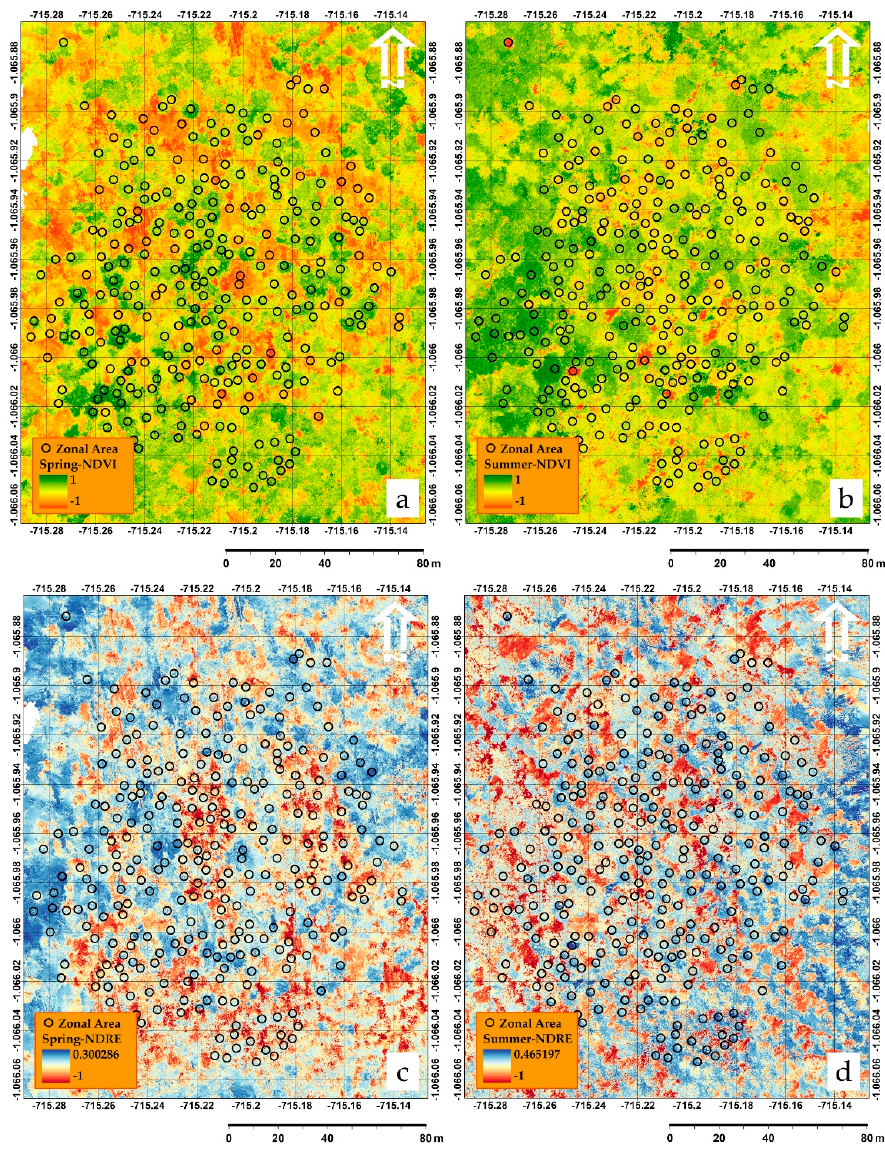
Figure 5. ( a ) Showing the application of normalized difference vegetation index (NDVI) in spring ( b ) NDVI in summer ( c ) showing the normalized difference red-edge index (NDRE) in spring and ( d ) NDRE in summer (see details in Section 2.5). Table 3. Reflectance indices used in chronological order.